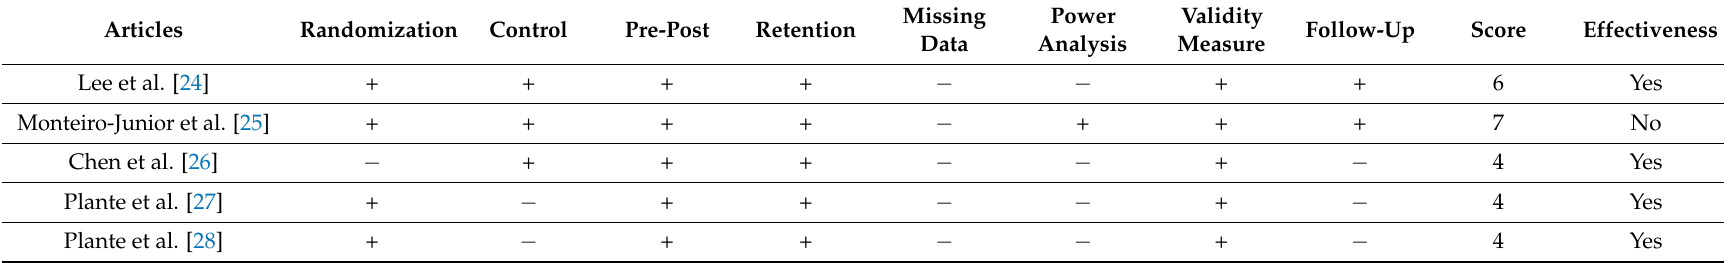
Table 1. Design Quality